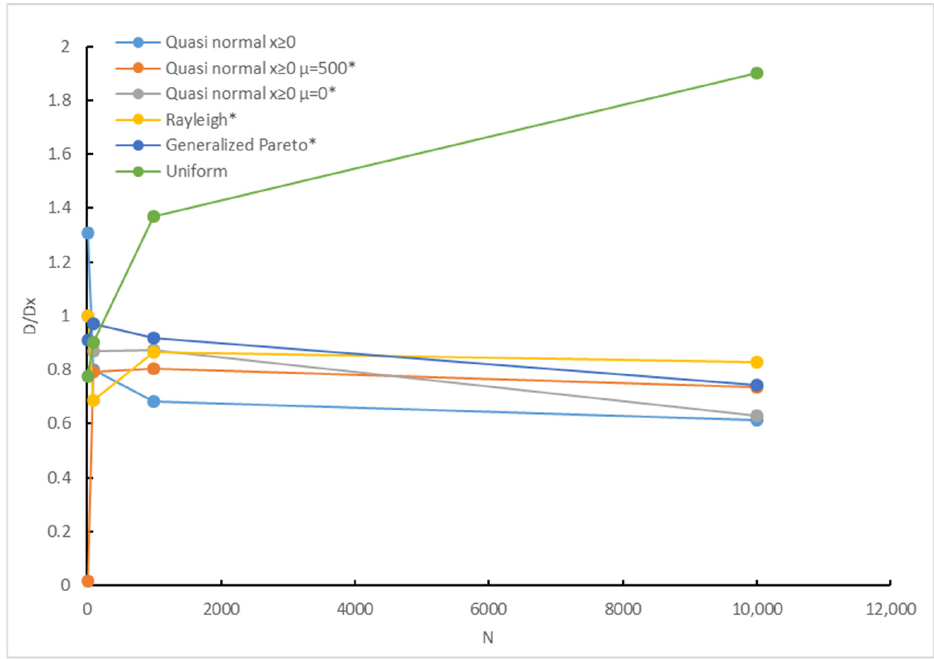
Figure 5. Dependence of the maximum delay estimation on the sample size for the maximum service curve γ (cid:48) , N is a sample size. The symbol * means the data is measured in a real computational environment; the data without * are generated with a random number generator.